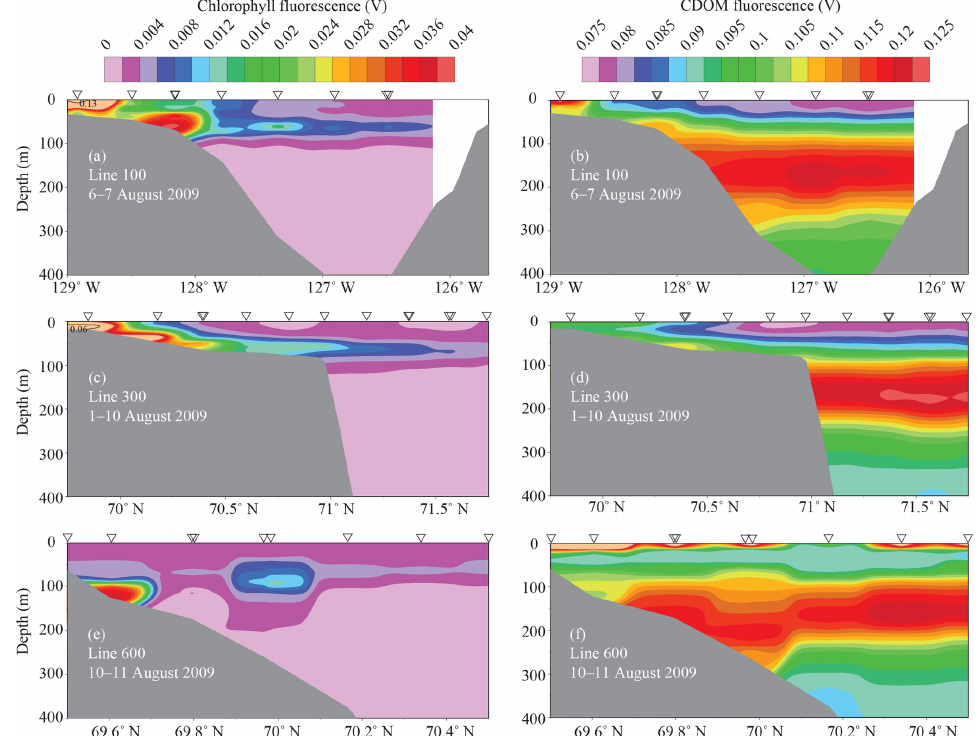
Figure 4. Voltage readings from the chlorophyll fluorometer (a, c, e) and CDOM fluorometer (b, d, f) for transects (a–b) 100, (c–d) 300, and (e–f)